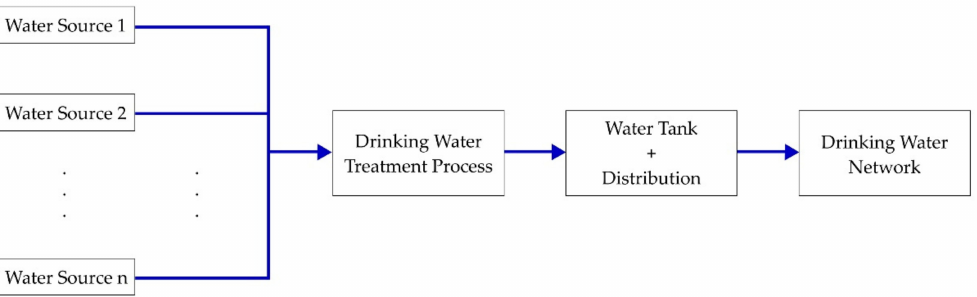
Figure 1. Simplified overview of the stages taken by the drinking water before entering the consumer